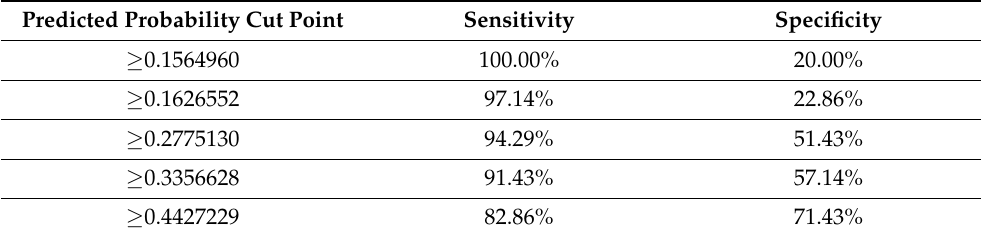
Table 5. Saturated multivariate logistic regression model including all selected exosomes (APOA, HBB, CA1, LPA, SAA4, PF4V1, APOE, and HBD), with the outcome Stage 1 EC patients vs. con- trols.